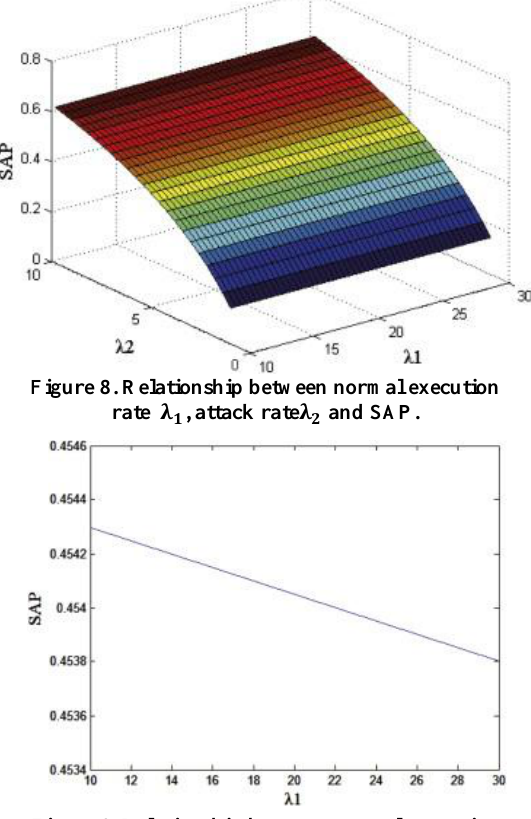
Figure 9 . Relationship between normal execution rate 𝛌 𝟏 and SAP.